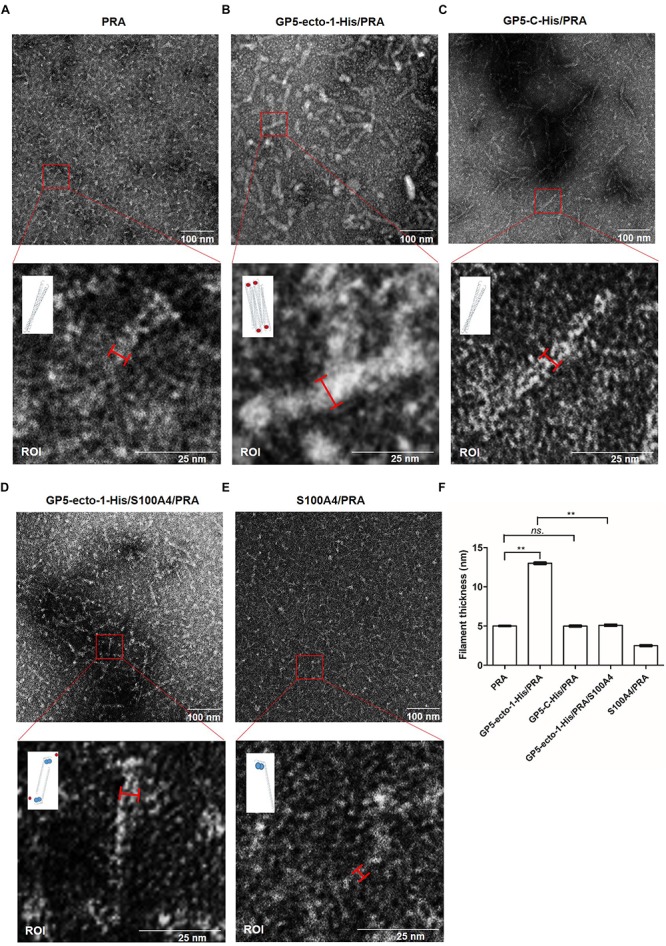
PRA filament assembly in vitro is mediated by its interaction with GP5-ecto-1-HA. Negatively stained fields of PRA alone (A), GP5-ecto-1-PRA complex (B) and GP5-C-PRA complex (C). Purified PRA (5 mM) alone or pre-incubated with purified GP5-ecto-1-His (10 mM) or GP5-C-His (10 mM) for 1 h at 4°C prior to structure analysis. After centrifuging, each supernatant sample (20 μL) was applied to a carbon-coated grid followed by staining with 1% uranyl acetate. Grids were examined using an H-7650 electron microscope (Hitachi, Tokyo, Japan) operating at 80 kV. Negatively stained fields of GP5-ecto-1-S100A4-PRA complex (D) andS100A4-PRA complex (E). Purified S100A4 (10 mM) incubated with complex of GP5-ecto-1-His/PRA or PRA for 1 h at 4°C and sample preparation was performed as described in panel (A) Results are representative of three independent experiments. The results of the width of long helical structure were expressed as the mean wide values obtained from ten individual protein complexes ±SD. The schematic diagram of protein complexes was showed in the ROI pictures. PRA filament, GP5-ecto-1-His and S100A4 were represented as long double helix, red circles and blue circles, respectively. Scale bars represent 100 nm in the top panels and 25 nm in the bottom panels. (F) The filament width of long helical structures described in A–E were assessed as mean ± SD which are representative of ten individual protein complexes. ∗∗P < 0.01; ns., no significance.